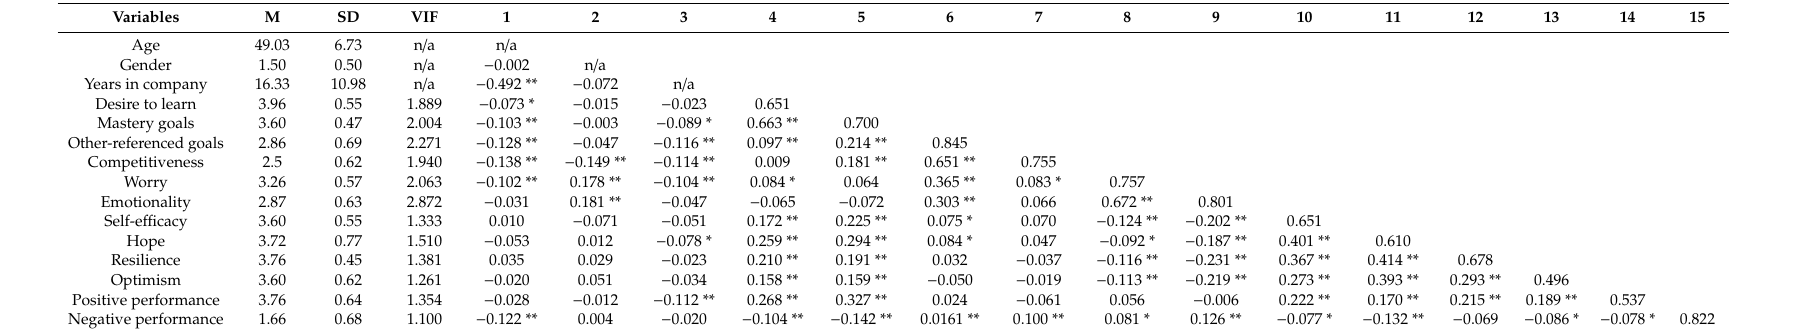
Table 1. Descriptives, Pearson Correlations, and Indicators’ Collinearity